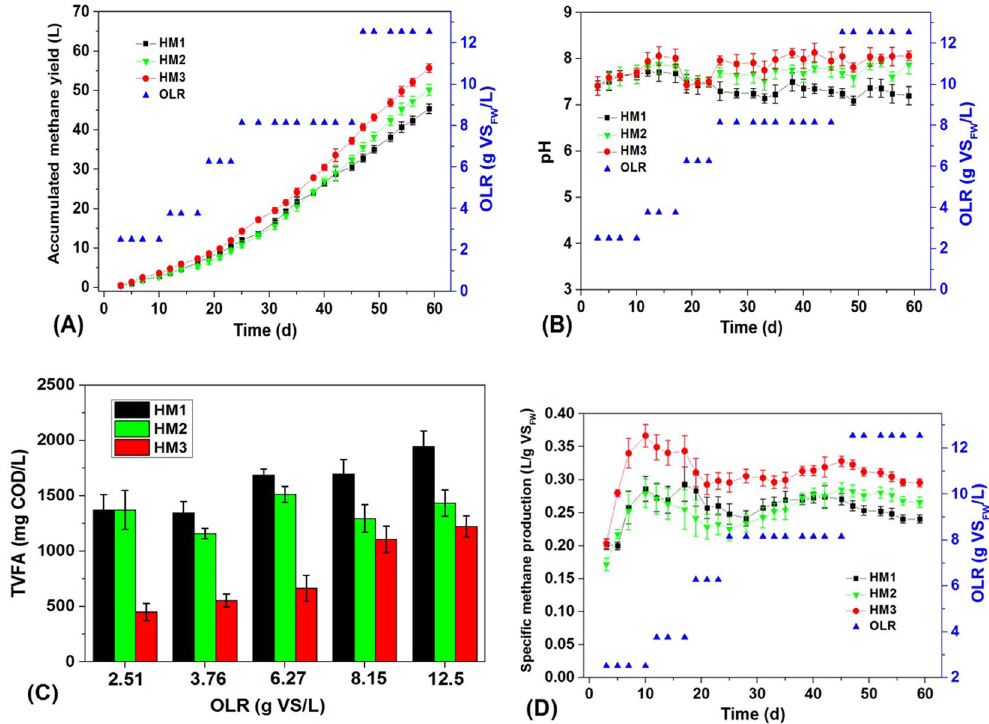
Figure 2. Comparison of ( A ) accumulated methane yield, ( B ) pH, ( C ) TVFA concentration and ( D ) Specific methane production among the three ADs (HM1, HM2 and HM3).